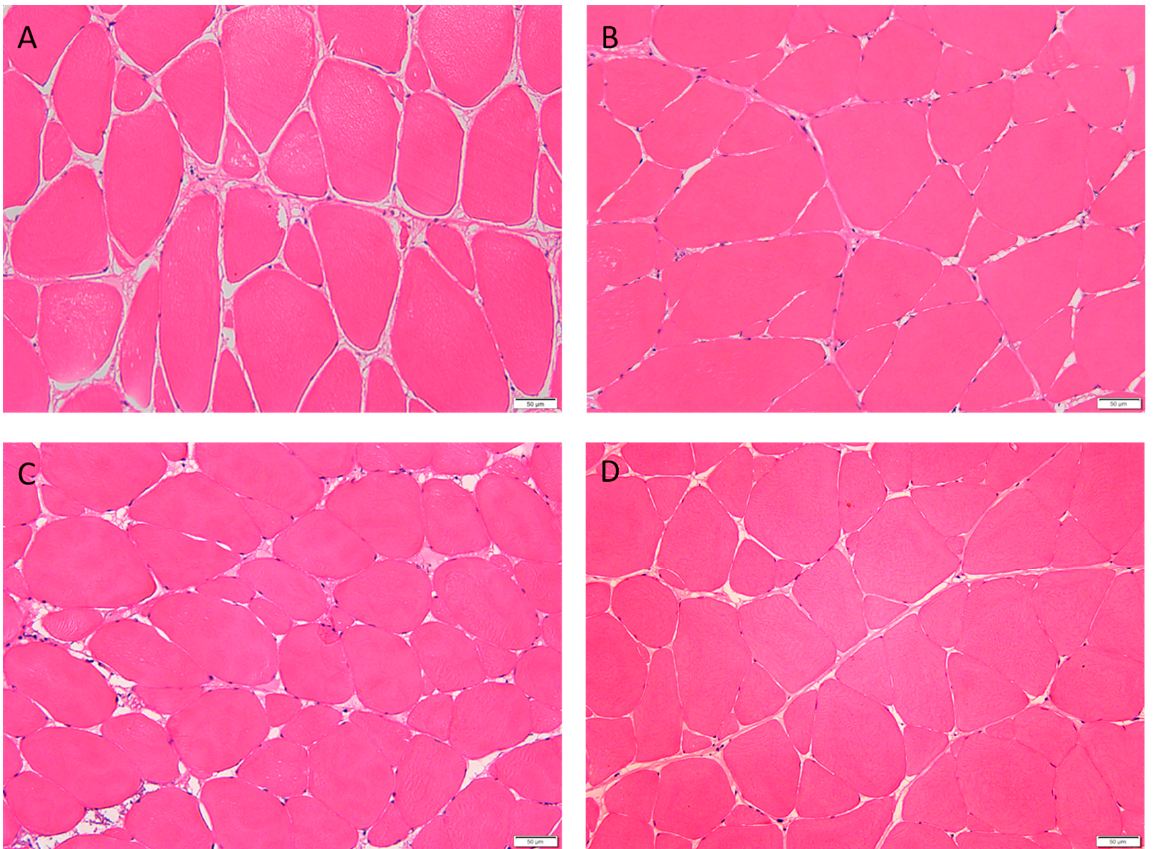
Figure 1. Muscle histology of triploid crucian carp fed with different diets (200 × ). ( A ): Control group; ( B ): 2% HC group; ( C ): 4% HC group; ( D ): 6% HC group.